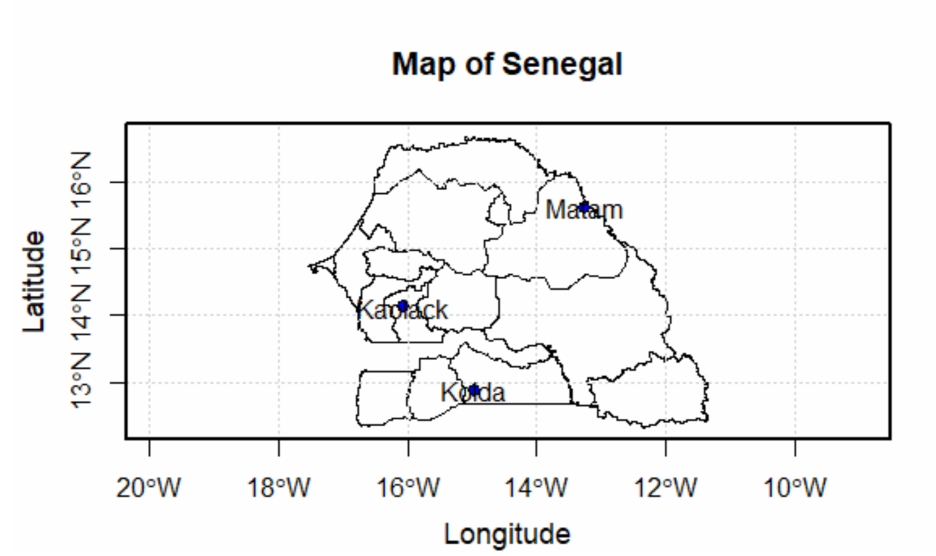
Figure 2. Map of Senegal showing locations for exploratory data analysis.